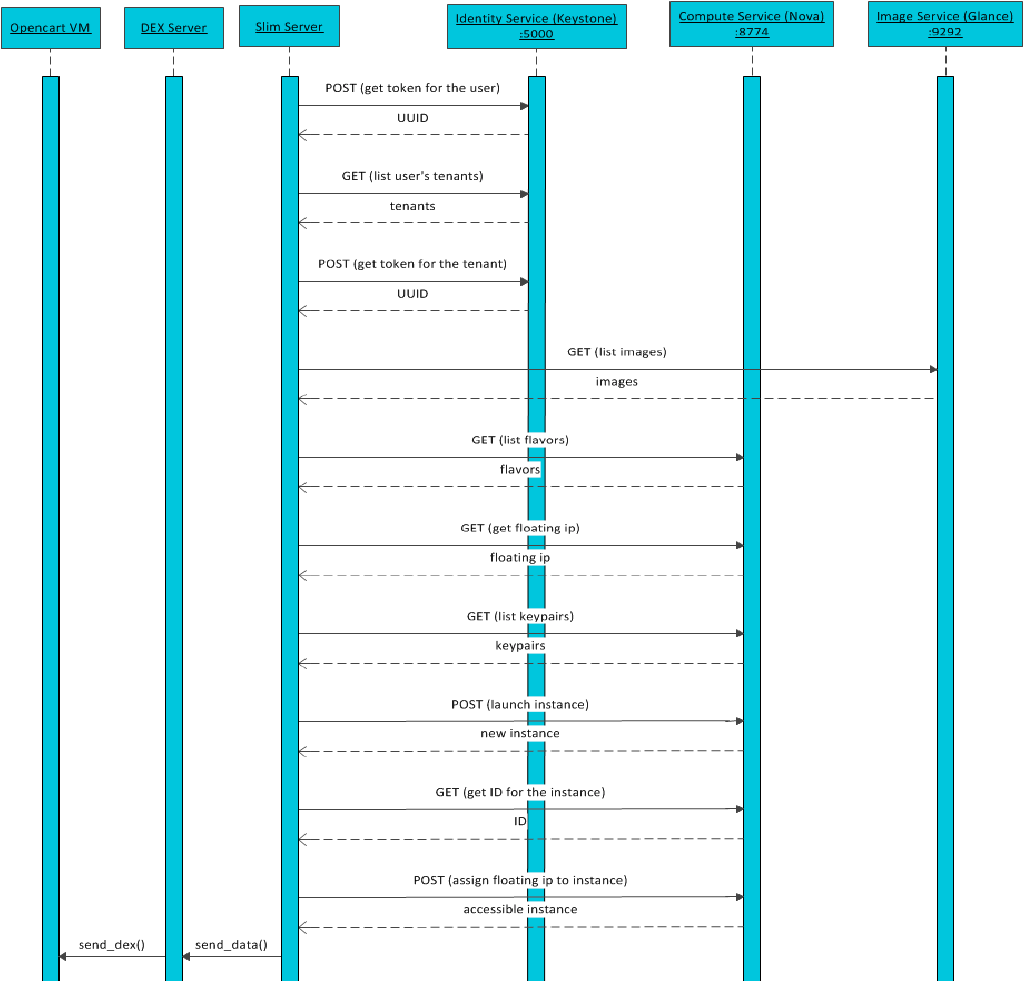
Figure 9. Sequence flow between SLIM and OpenStack’s components to instantiate OpenCart.